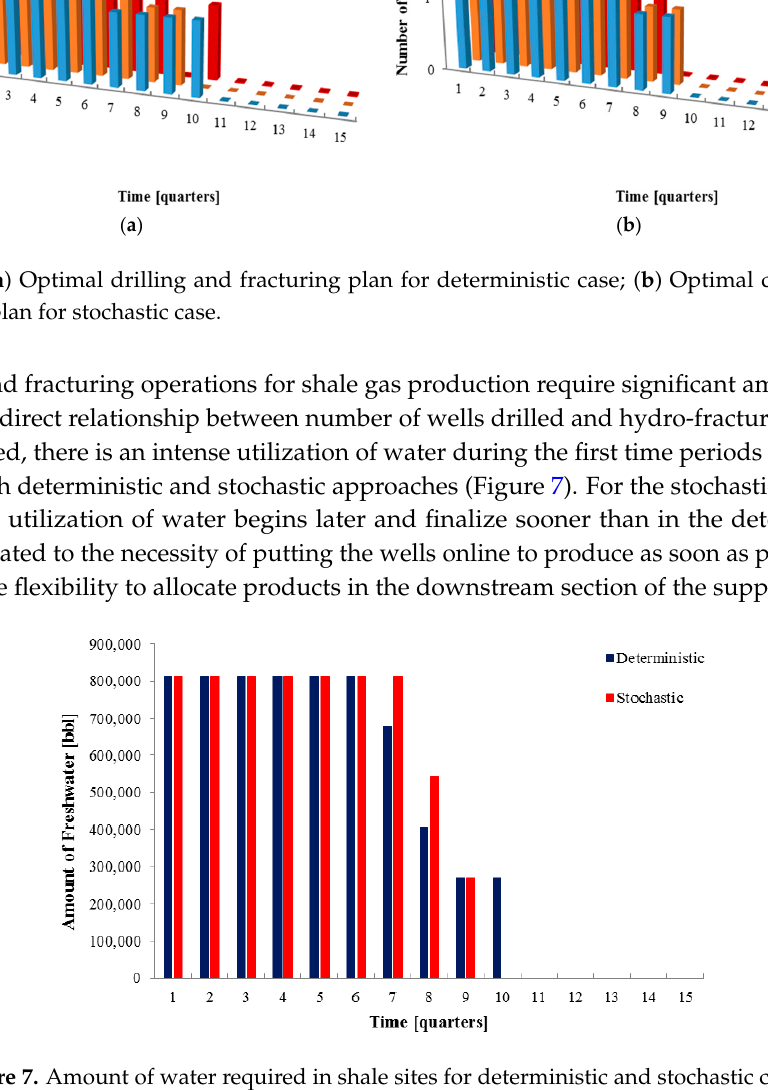
Table 2. Comparison of deterministic and stochastic cases. Net Present Value (MMUS$)